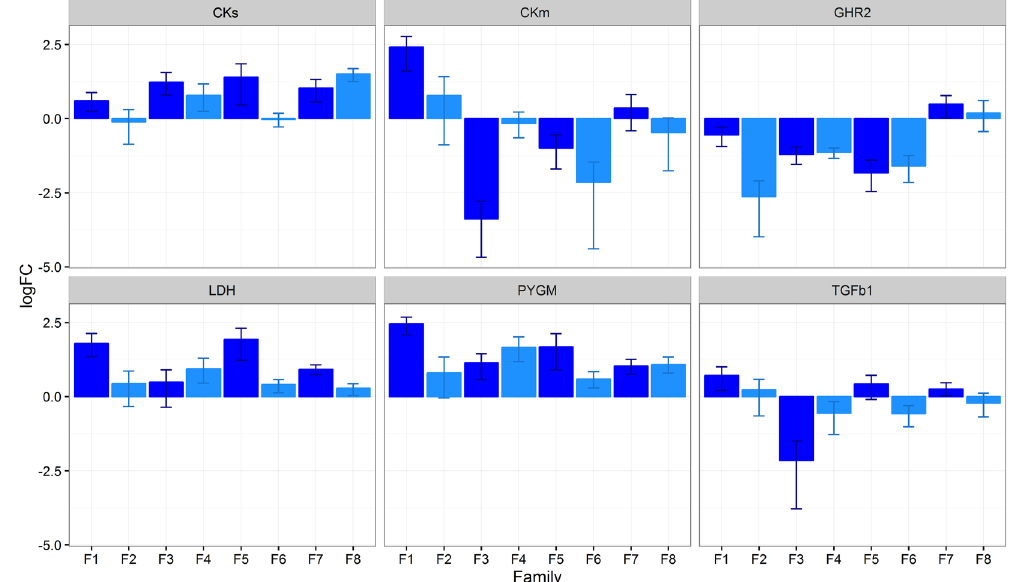
Figure 2. Family expression differences for six candidate genes. Log2 fold change differences between fast- and slow-growing fish in each family for six candidate genes studied by qPCR. Positive fold changes indicate over expression in fast-growing fish. The genes are lactate dehydrogenase (LDH), muscle glycogen phosphorylase (PYGM), growth hormone receptor 2 (GHR2), cytosolic creatine kinase (CKs), mitochondrial creatine kinase (CKm), and transforming growth factor β 1 (TGFb1).